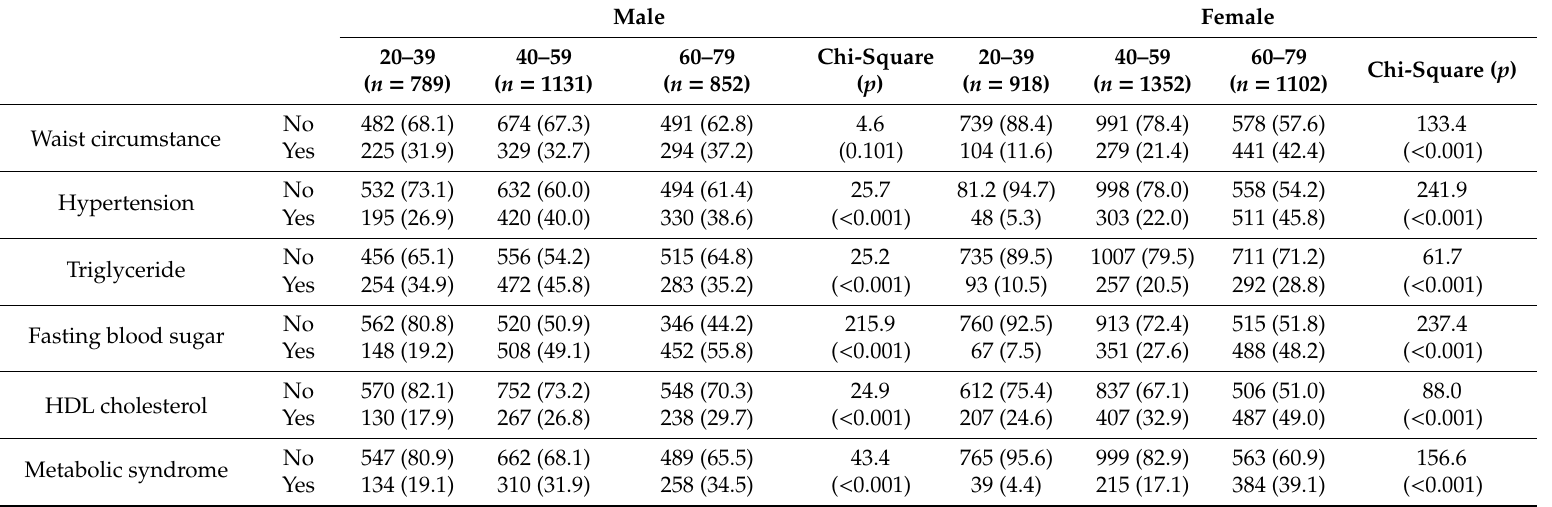
Table 2. Prevalence of metabolic syndrome components according to sex and age groups ( n ,